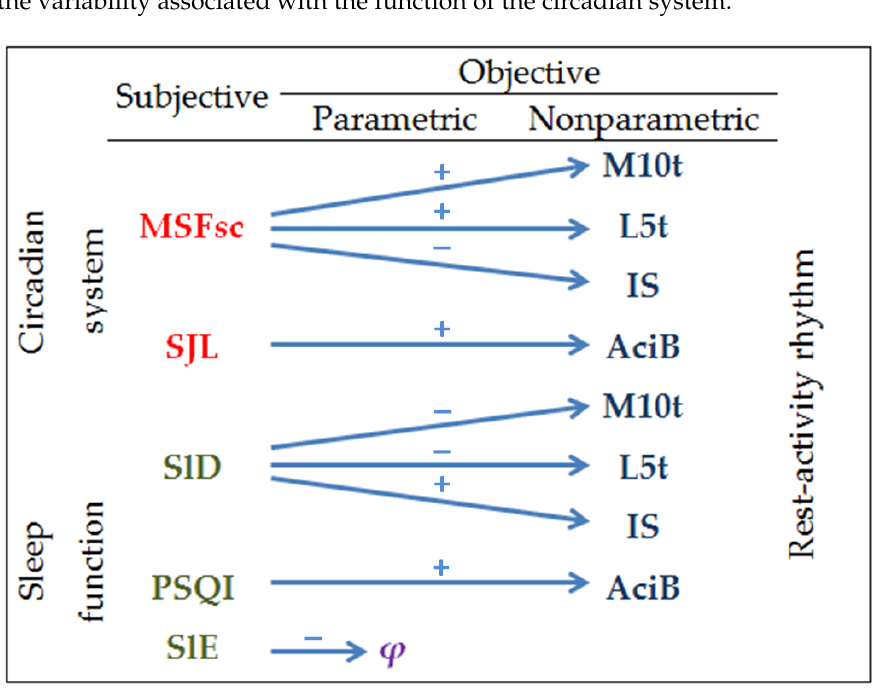
Figure 3. Associations among subjective and objective indices.